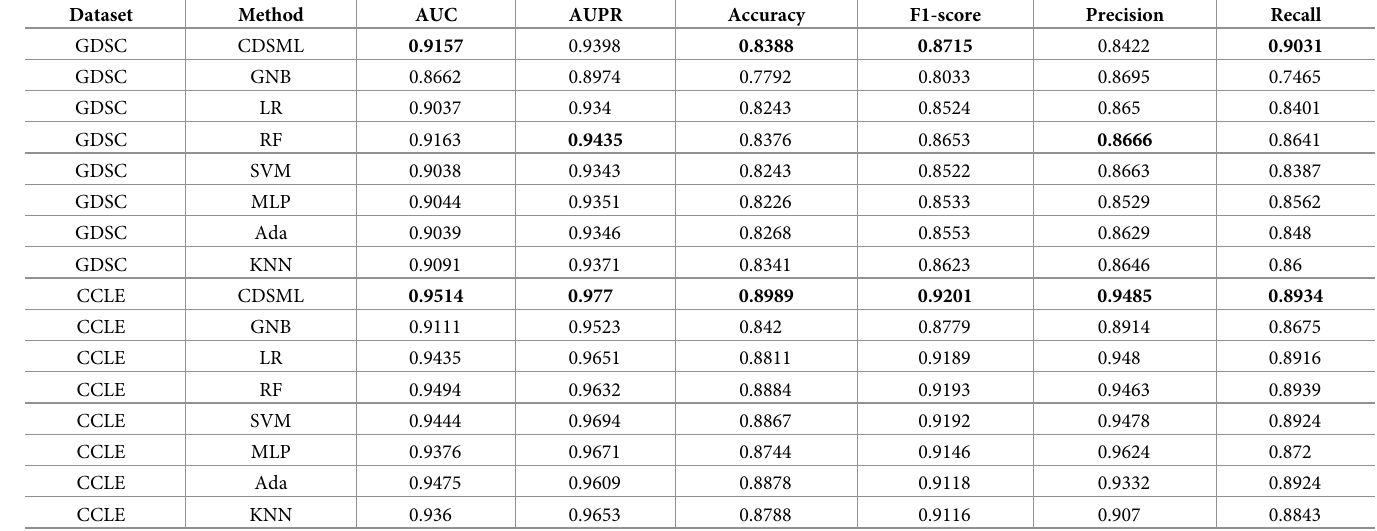
Table 8. Comparison of CDSML’s performance with off-the-shelf methods’ performance on GDSC and CCLE. The assessments were done by averaging 30 repetitions of stratified five-fold cross-validation. The highest value of each criterion is shown in bold.